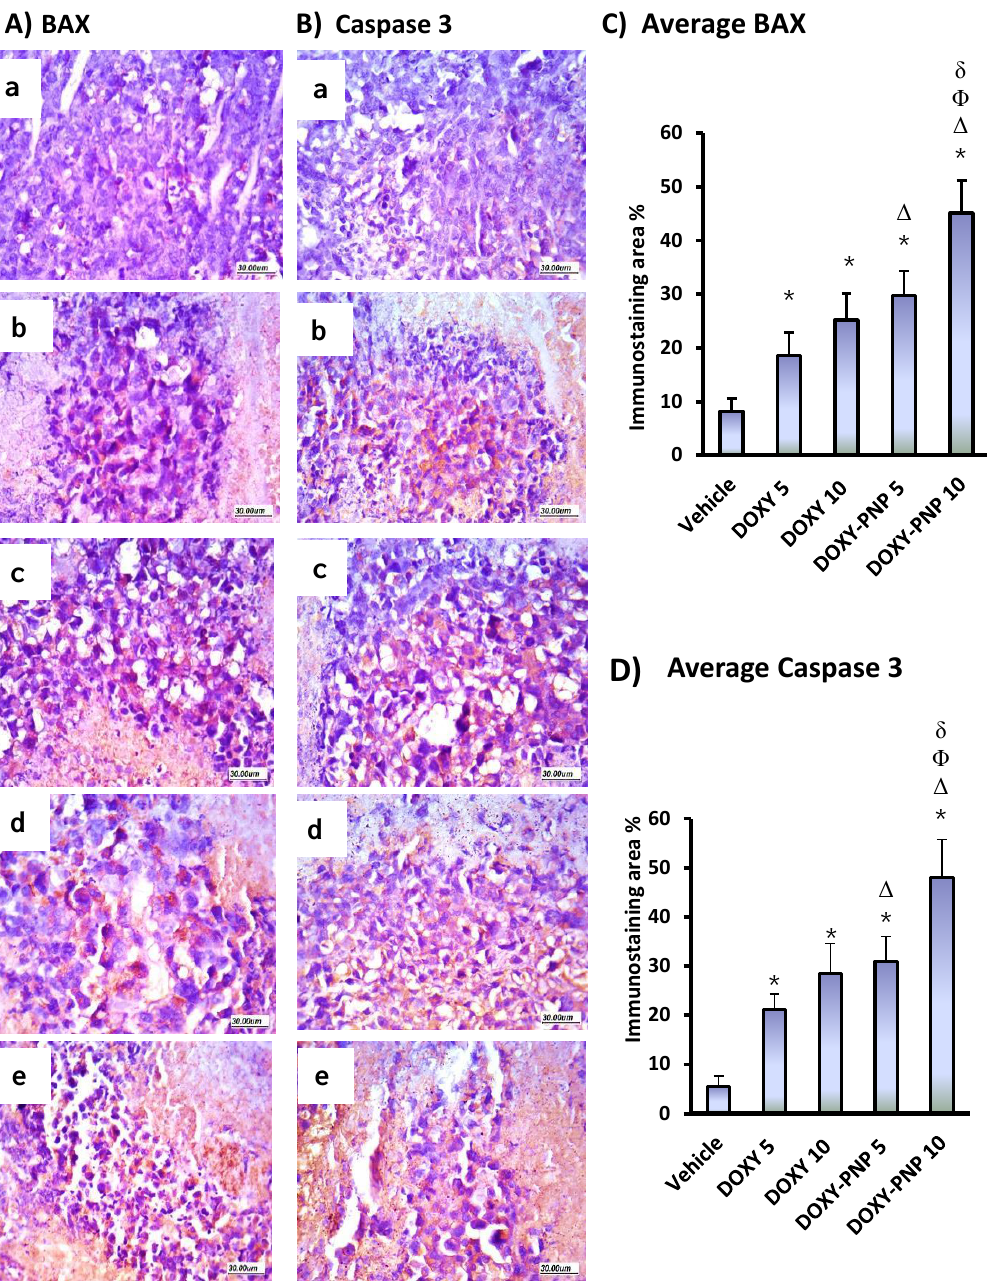
Figure 8. Immunohistochemical staining for BAX and caspase 3 in solid tumors. ( A ) Images for tumor specimens stained for BAX protein in different groups ( a —vehicle; b —DOXY 5; c —DOXY; d —DOXY-PNPs 5; e —DOXY-PNPs 10), ( B ) images for tumor specimens stained for caspase 3 in different groups ( a–e ), ( C , D ) column charts demonstrating the mean area of staining ± SD for BAX and caspase 3. Data were analyzed using multivariate ANOVA followed by Bonferroni’s post-hoc test at probability value <0.05. *Versus vehicle, Δ versus DOXY 5 mg/kg, Φ versus DOXY 10 mg/kg, δ versus DOXY-PNP 5 mg/kg, n = 6.